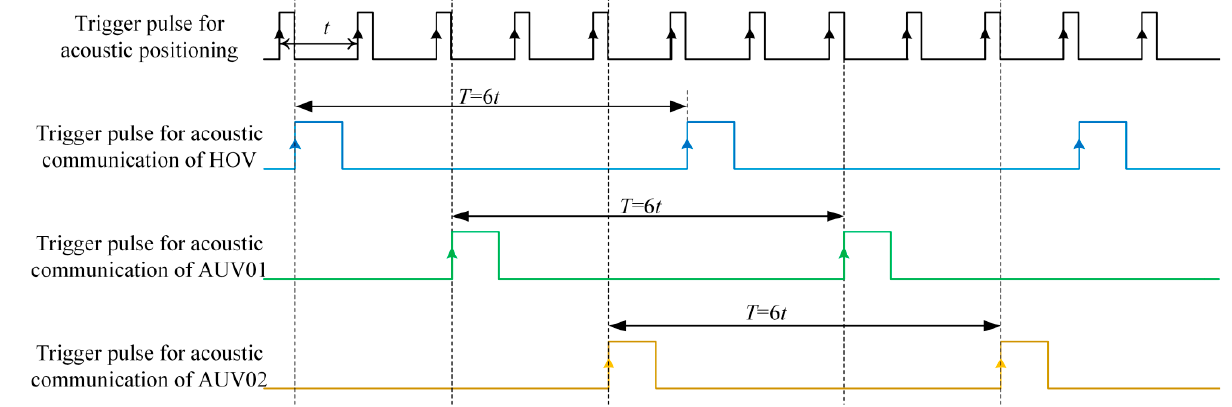
Figure 13. Time sequence allocation of underwater positioning communication.